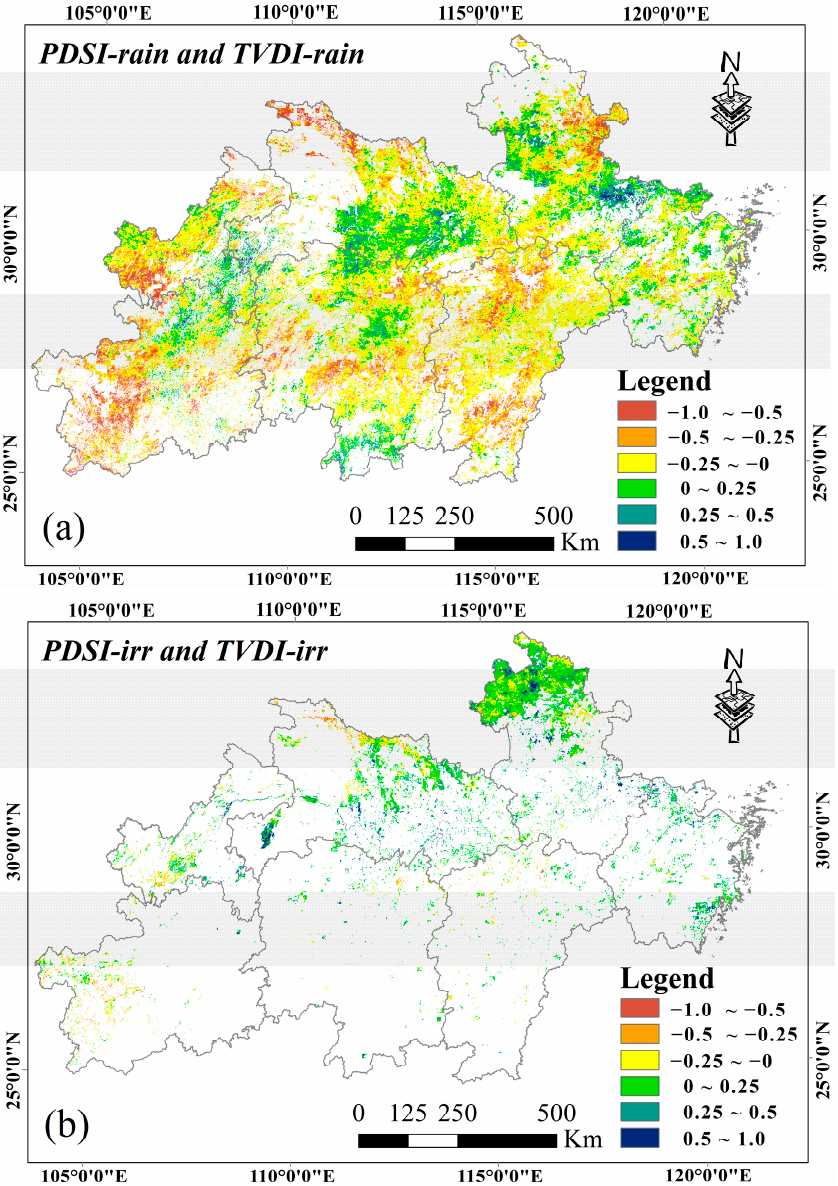
Figure 14. Spatial patterns of the correlation coefficient between the PDSI and TVDI based on annual averages in the middle and lower reaches of the Yangtze River from 2010 to 2015. Passed the significance test, with p < 0.05. ( a ) The PDSI and TVDI of rain-fed arable land. ( b ) The PDSI and TVDI of irrigated arable